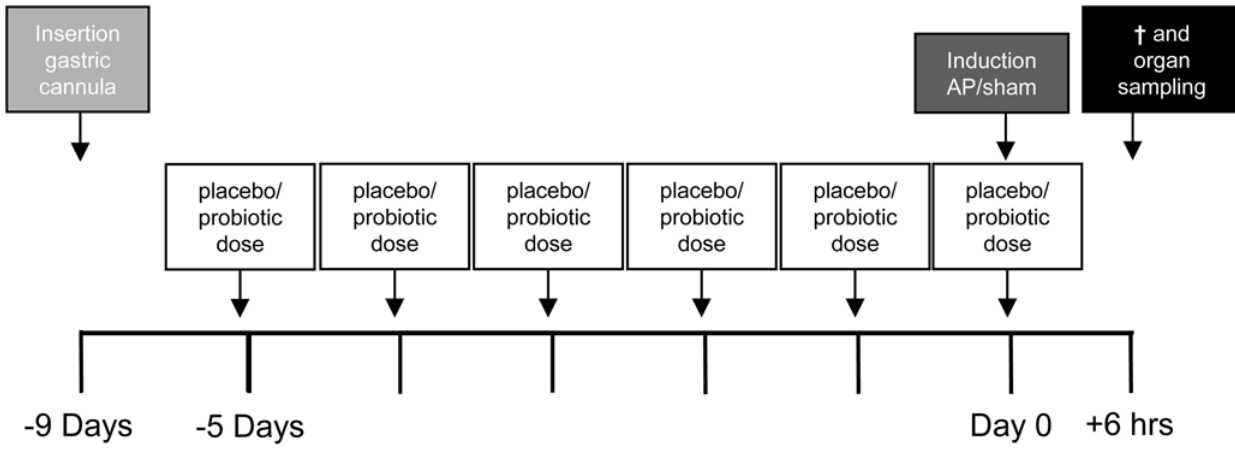
Figure 1. Experimental design. At the start of the experiment, animals were fitted with a gastric cannula, except for control animals. Probiotics and placebo were administered daily to the probiotics and placebo group, starting 5 days prior to induction of acute pancreatitis (AP). At day 0, AP or sham-procedure was performed. After the six hours of cerulein infusion, animals were anesthetized for removal of organ samples.